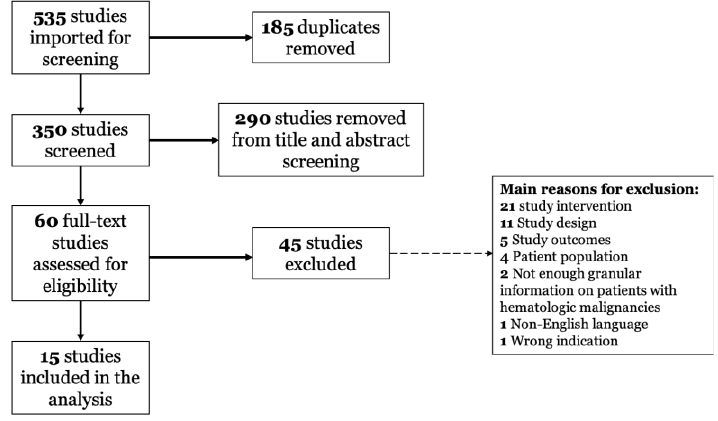
Figure 1. PRISMA diagram of studies assessed for eligibility of inclusion in the study.